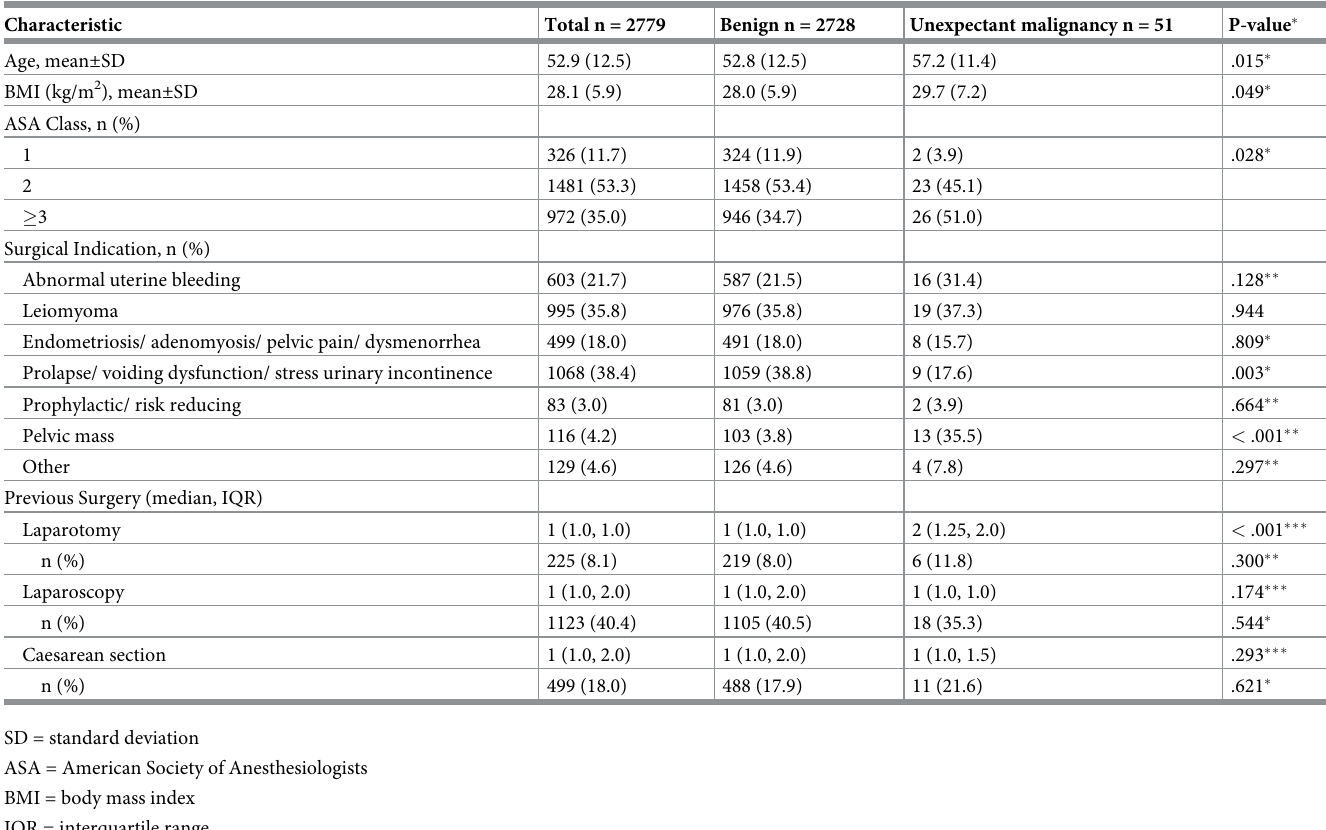
Table 2. Preoperative patient characteristics of patients with benign and unexpected malignant